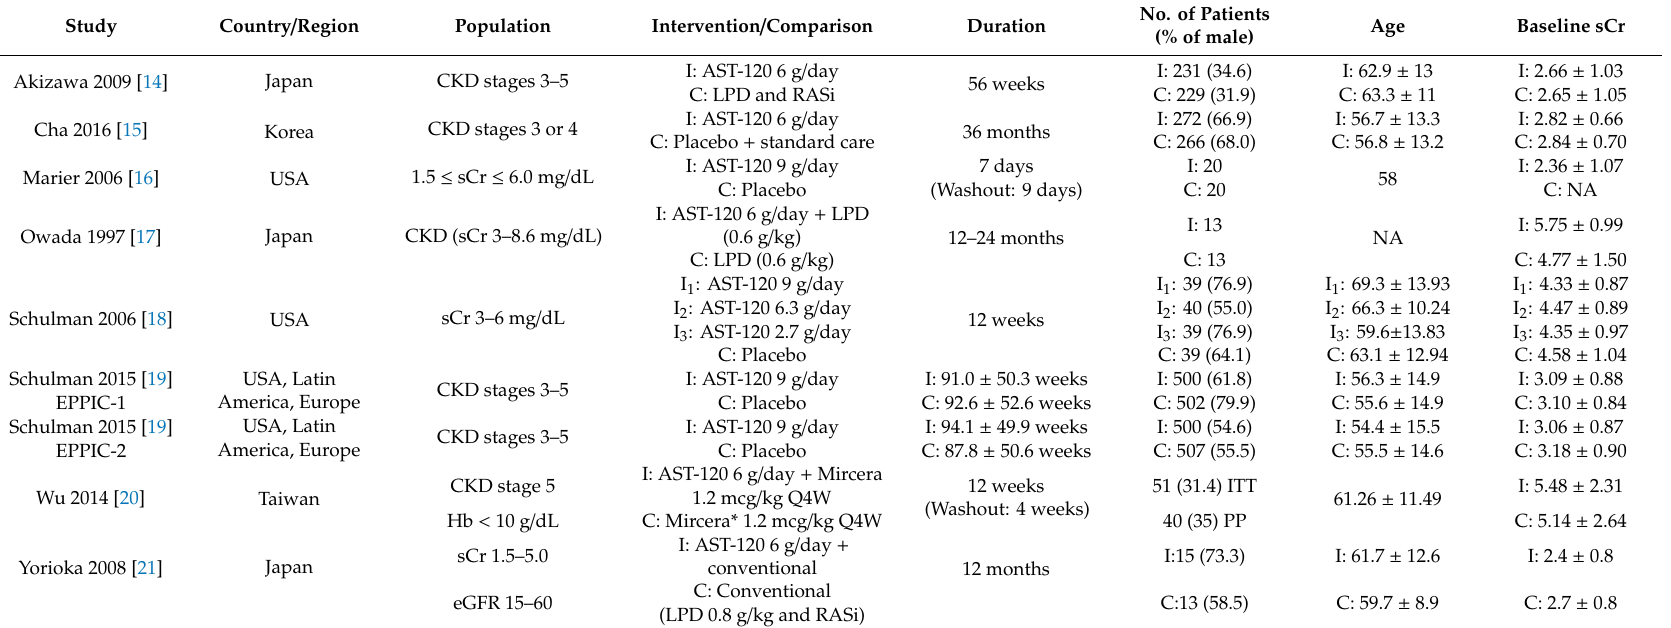
Table 1. Characteristics of included